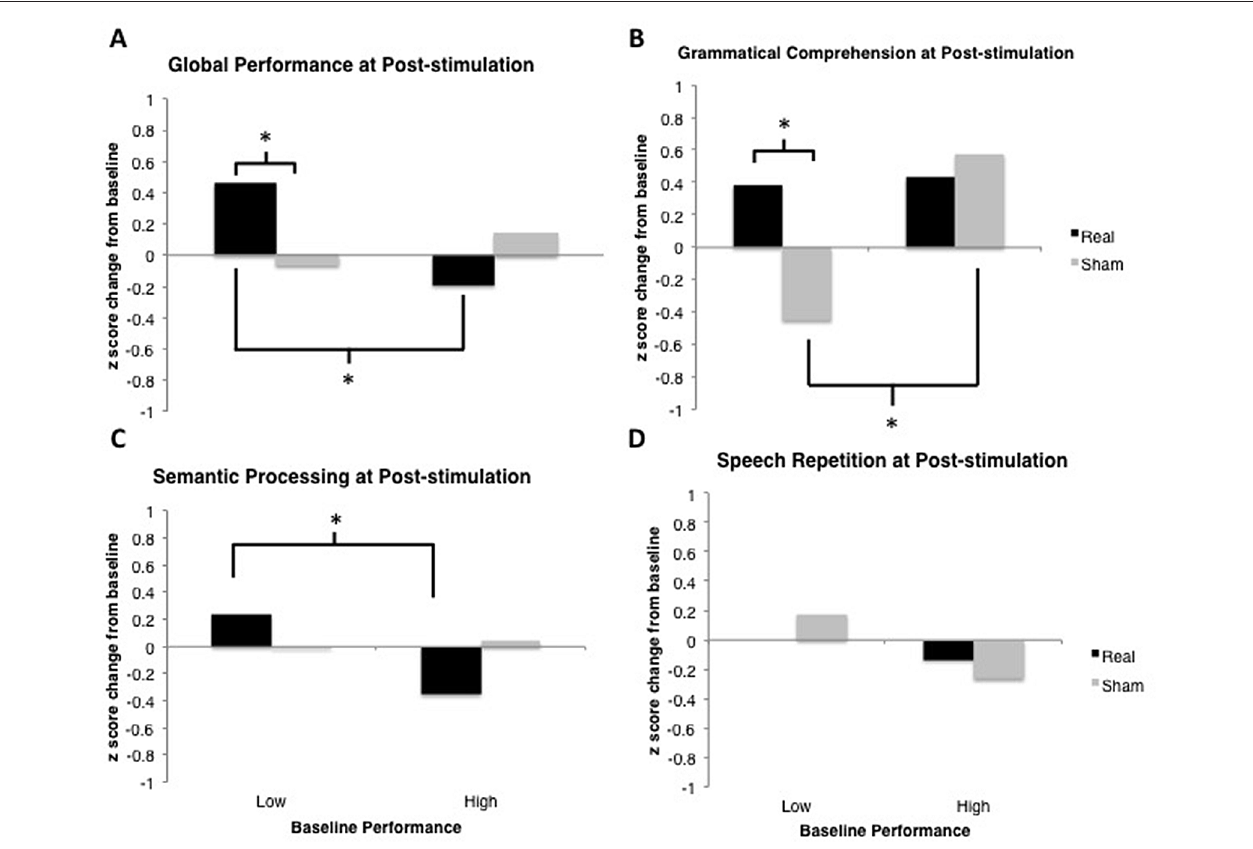
FIGURE 6 | Results from the post-stimulation time-point only. Model-estimated means are plotted in units of z-scores measured as change relative to the most recent baseline (i.e., standardized different scores). Asterisks represent significant comparisons at the p < 0.05 level. (A) Global Performance at post-stimulation